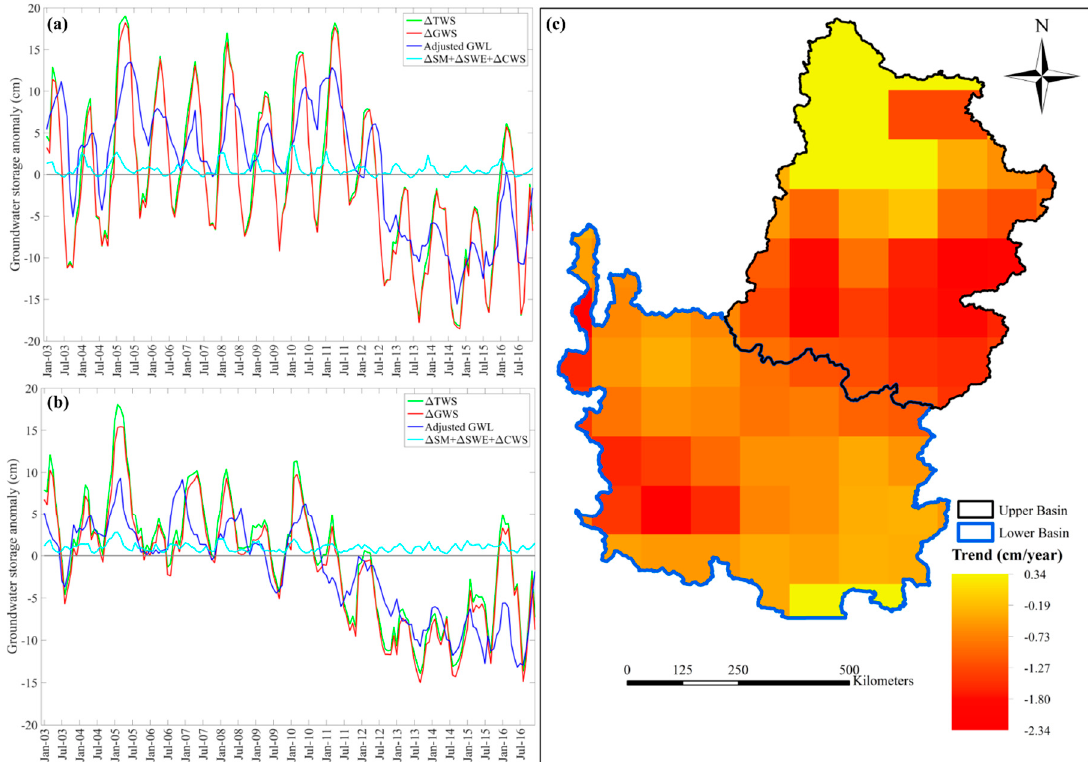
Figure 3. Average monthly time series of each hydrological component for the period of January 2003–December 2016 for ( a ) Upper Colorado River Basin and ( b ) Lower Colorado River Basin; ( c ) Spatial variation of Thiel Sen Slope at the significance level of p ≤ 0.05. The significance of the trend was obtained with the Mann-Kendal test.